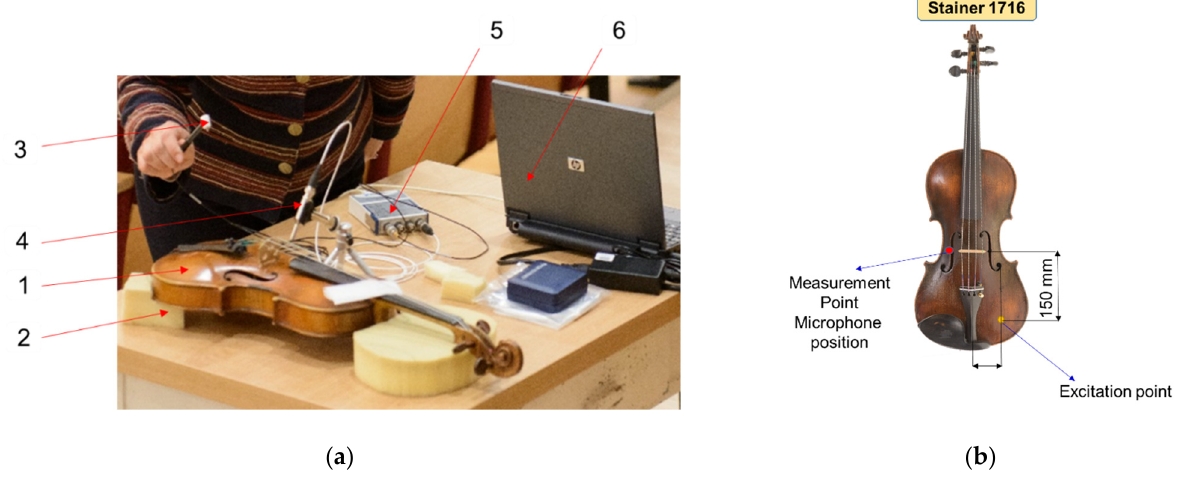
Figure 4. Violin testing: ( a ) excitation with the impact hammer; ( b ) the positions of excitation and measurement points. Legend: 1—tested violin; 2—elastic support; 3—impact hammer for light structures; 4—microphone; 5—data acquisition board; 6—laptop (software).